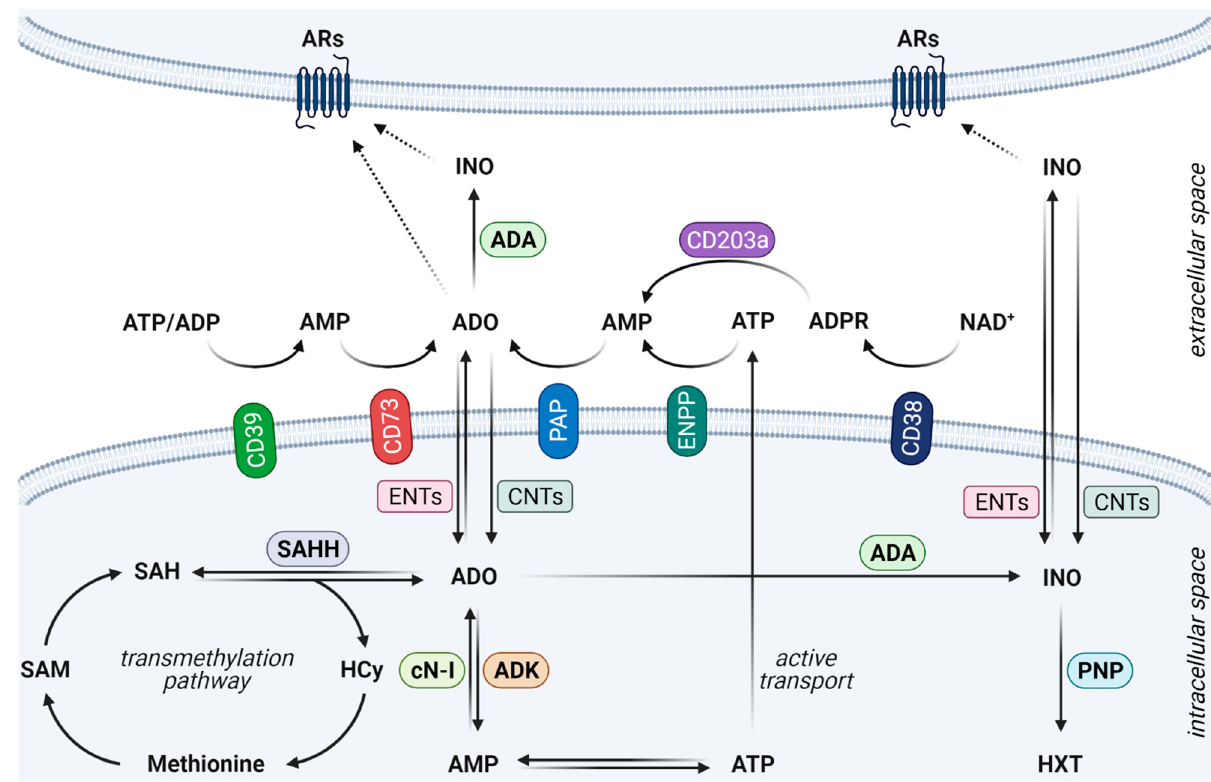
Figure 1. An overview of ADO production, metabolism, transport and signalling. ATP is actively transported from cells by the non-lytic mechanisms (connexin and pannexin hemichannels and other transporters) or uncontrollably released after stress stimuli. Extracellular ATP is hydrolysed by CD39 and CD73 ectonucleotidases to ADO. ADO could be also produced by ENPP and PAP enzymatic activity or alternatively by CD38 from NAD + . ADO is further metabolised to INO by ADA, and INO is converted to HXT by PNP. ADO is also important for the transmethylation pathway, and its intracellular availability is regulated by SAHH, ADK and cN-I. ADO and INO could be transported by ENTs (both directions) and CNTs (one-way transport). In the extracellular space, both ADO and INO interact with ARs in an autocrine and paracrine manner. ADA, adenosine deaminase; ADK, adenosine kinase; ADO, adenosine; ADP, adenosine diphosphate; ADPR, adenosine diphosphate ribose; AMP, adenosine monophosphate; AR, adenosine receptor; ATP, adenosine triphosphate; cN-I, cytoplasmic 5 ′ -nucleotidase-I; CNT, concentrative nucleoside transporter; ENPP, ectonucleotide pyrophosphatase/phosphodiesterase; ENT, equilibrative nucleoside transporter; HCy, homocysteine; HXT, hypoxanthine; INO, inosine; NAD+, nicotinamide adenine dinucleotide; PAP, prostatic acid phosphatase; PNP, purine nucleoside phosphorylase; SAH, S-adenosylhomocysteine; SAHH, S-adenosylhomocysteine hydrolase; SAM, S-adenosylmethionine. ADO was originally described as a cardiovascular system modulator in 1929 [12] and its primary extracellular targets, adenosine receptors (ARs), were first described in the 1970s. It has since become apparent that ADO and four ARs (A 1 R, A 2A R, A 2B R and A 3 R)